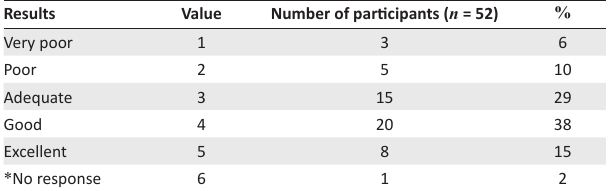
TABLE 5: Question 9c: Extent to which organs of state, including traditional authorities and other role players, are consulted in the drafting of the integrated development plans.